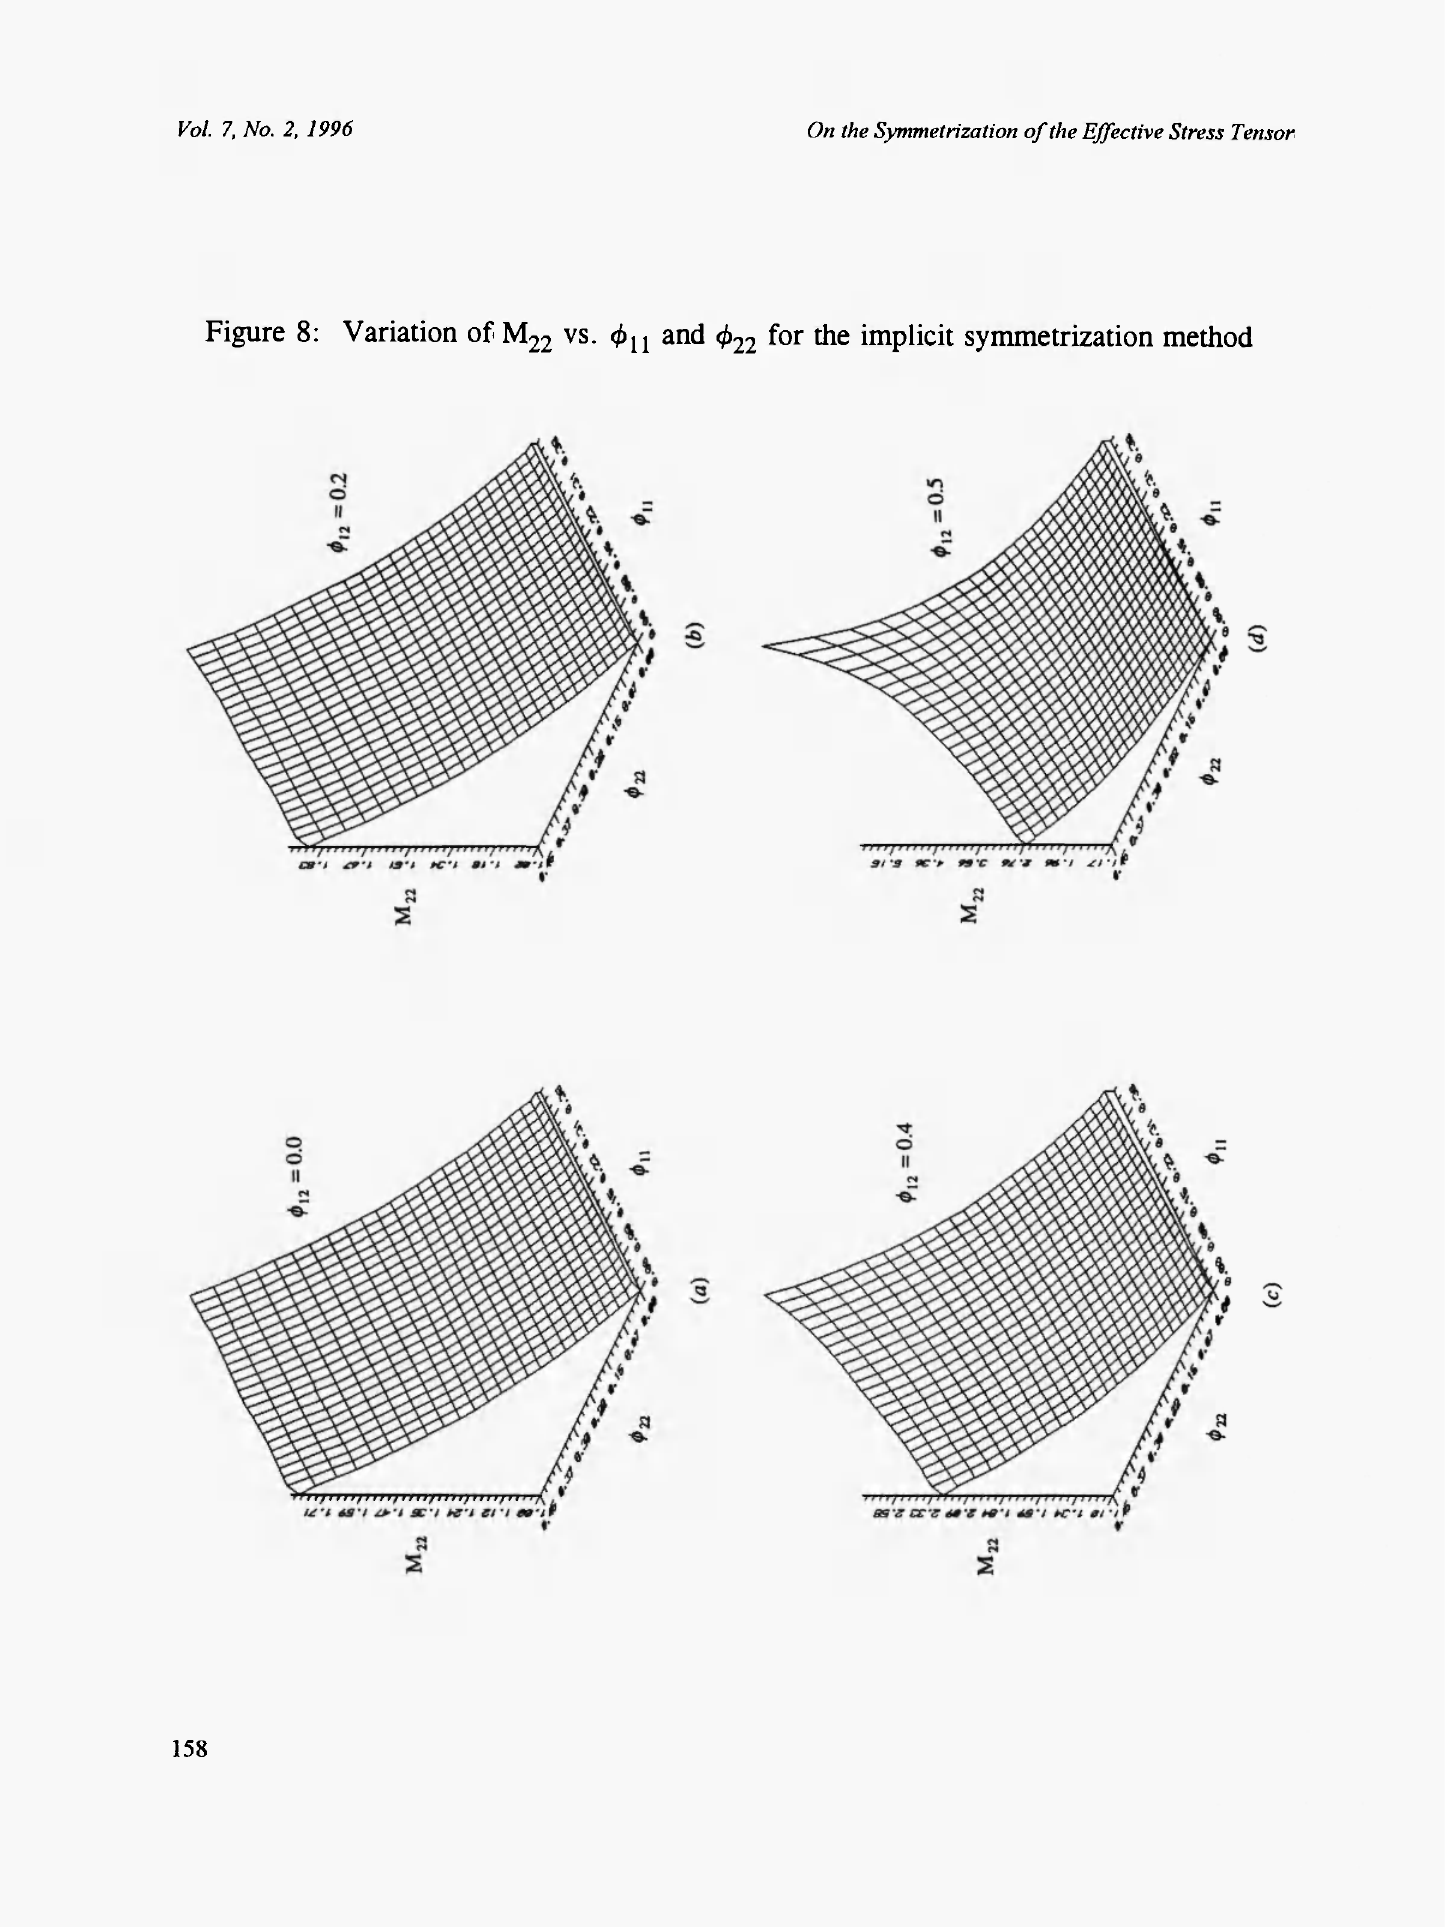
vs. φ and φ for the implicit symmetrization 22 η 22